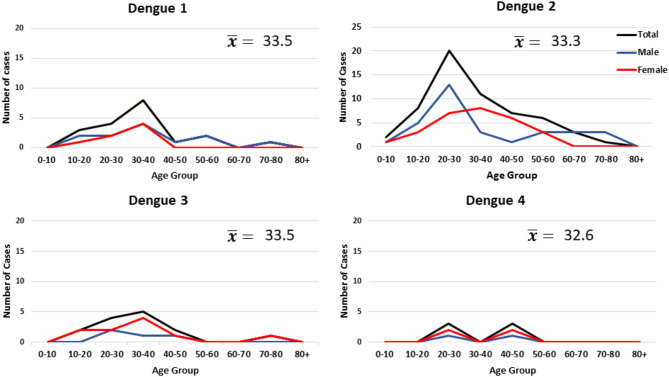
Age and gender of individuals infected with dengue virus. The data represents all primary and secondary infections.